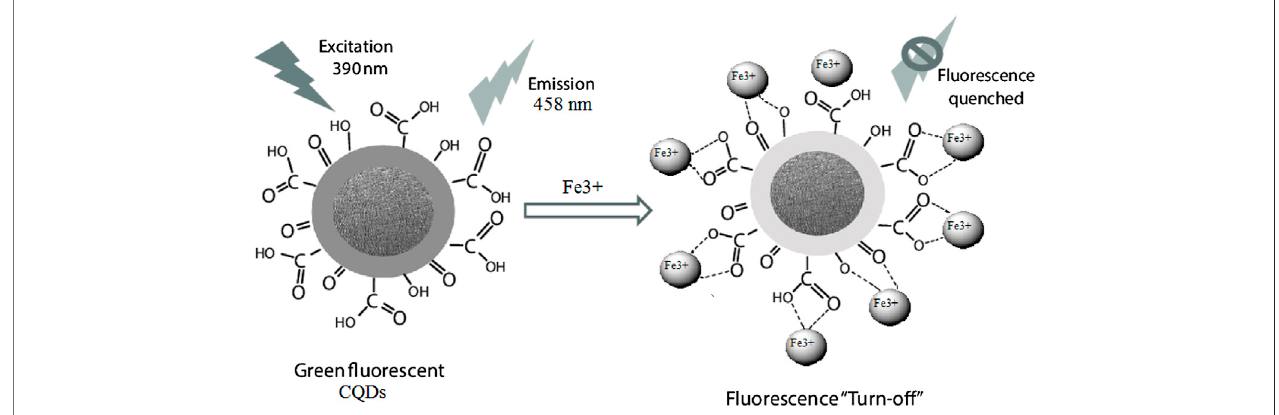
FIGURE 12 | Surface passivated green fl uorescence CQDs [positively charged ions (Fe 3+ ) or attracted by the negatively charged surface of the CQDs for sensing con fi rmation by fl uorescence quenching mechanism].